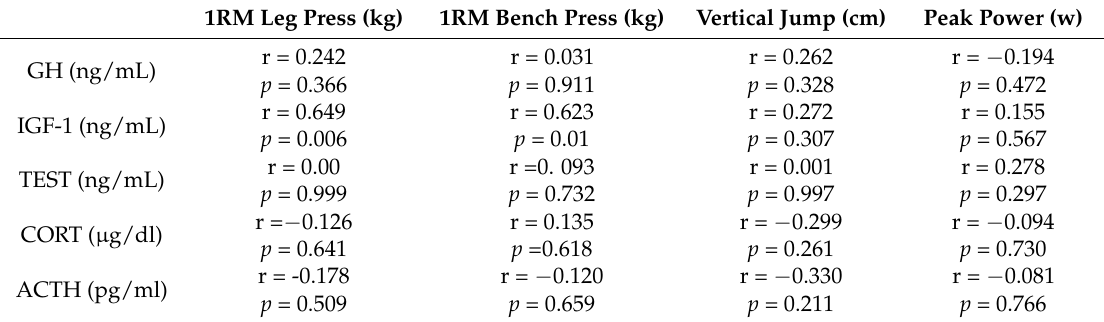
Table 4. Relationships between hormonal measures with strength and power in the post-training intervention ( n =